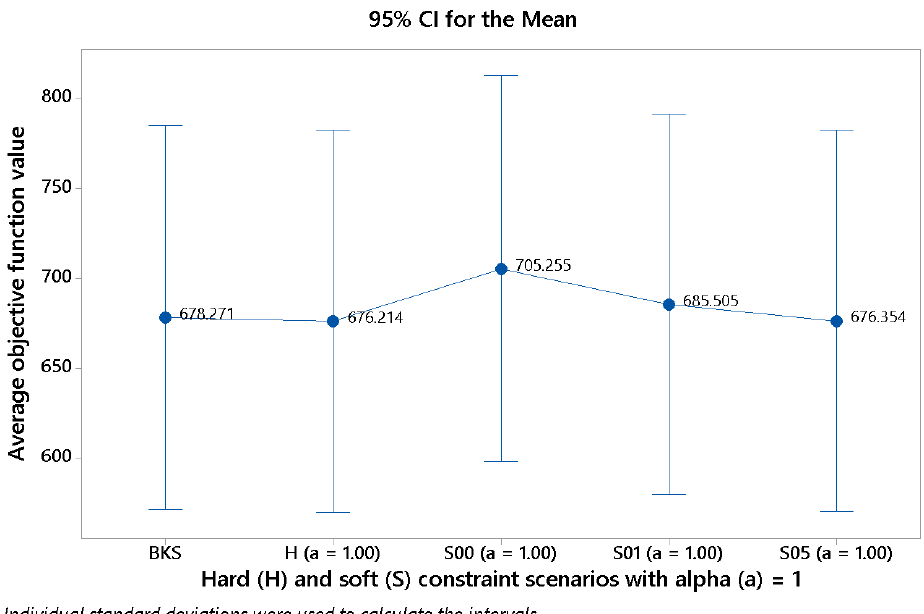
Figure 6. Results for different values of k with alpha a = 1 (source: own